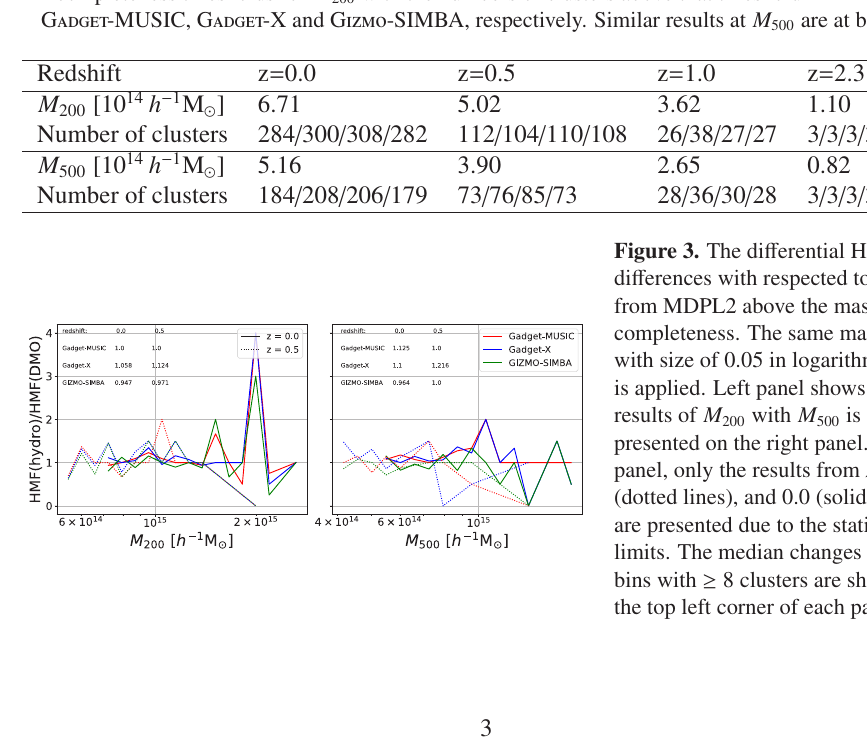
Figure 1. The halo mass di ff erences at M 200 (left panel) and M 500 (right panel) with respect to the DMO run. X-axis shows the halo masses from the DMO run. As indicated in the legend, di ff erent symbols with colours show di ff erent simulation runs. The errorbars show the 16 th 84 th percentiles. Only the − mass-complete sample is presented here. The horizontal dashed line marks the unit value of 1 with the two dotted lines show the 1 percent di ff erence in mass. Figure 2. The cumulative HMF from MDPL2 (solid black lines), G adget -MUSIC(red dashed lines), G adget -X(blue dotted lines) and G izmo -SIMBA(green dot-dashed lines). Left panel shows the results of M 200 with M 500 is presented on the right panel. In each panel, the results from z = 4 . 0 , 2 . 3 , 1 . 0 , 0 . 5, and 0.0 are presented from left to right, respectively. Vertical dashed lines show the mass-completeness limitation at each redshift.